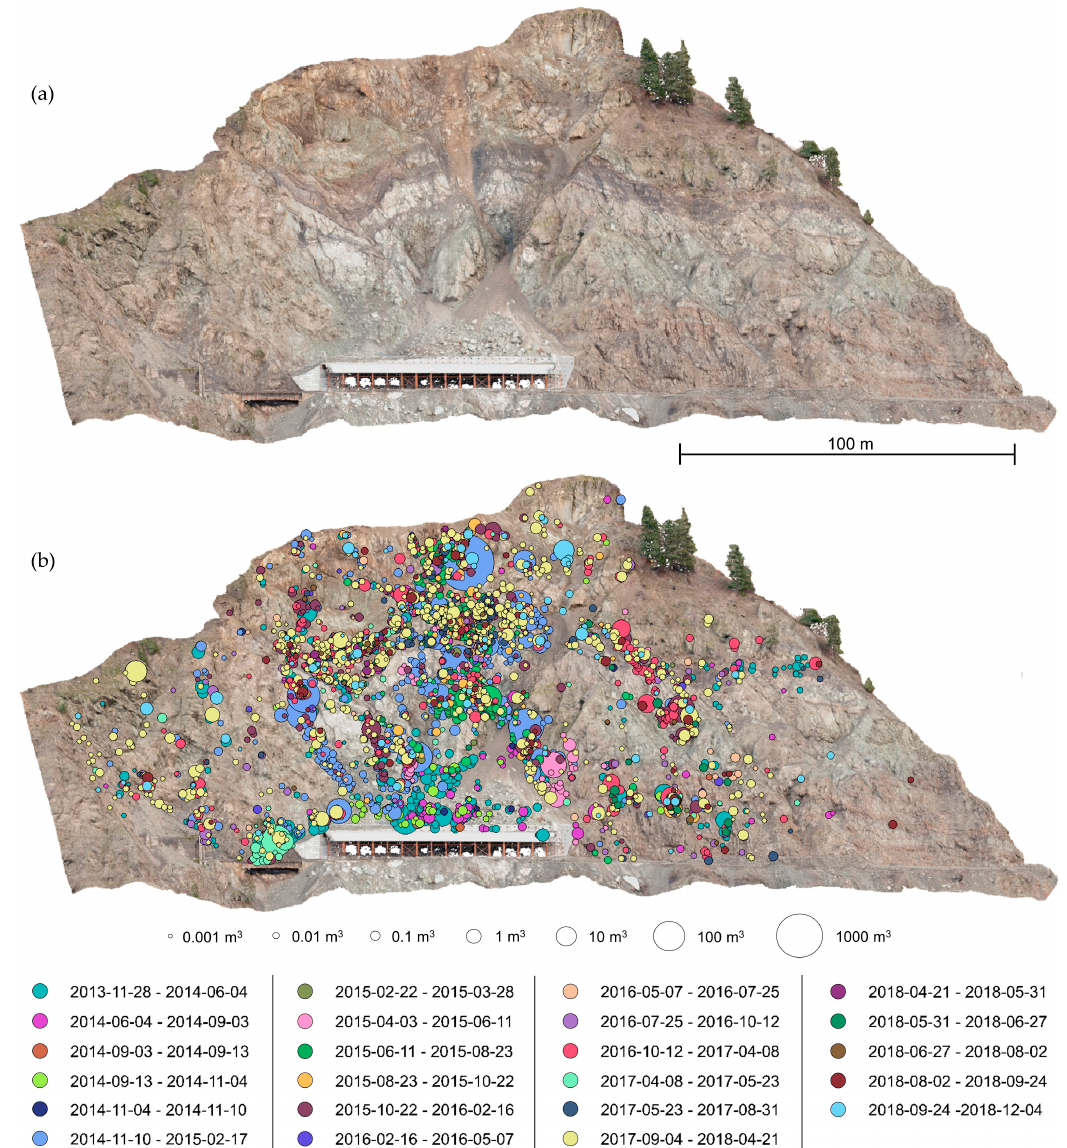
Figure 10. ( a ) The photogrammetry model; ( b ) The centroids of each extracted rockfall event from the 20 cm projection diameter inventory. This inventory contains the most extracted